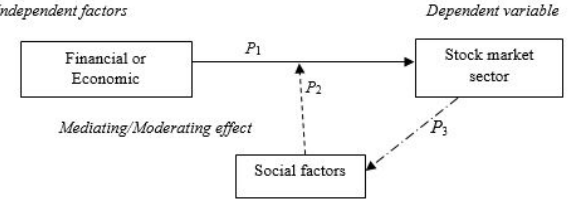
Fig. 7. Conceptual framework for future work (developed by the